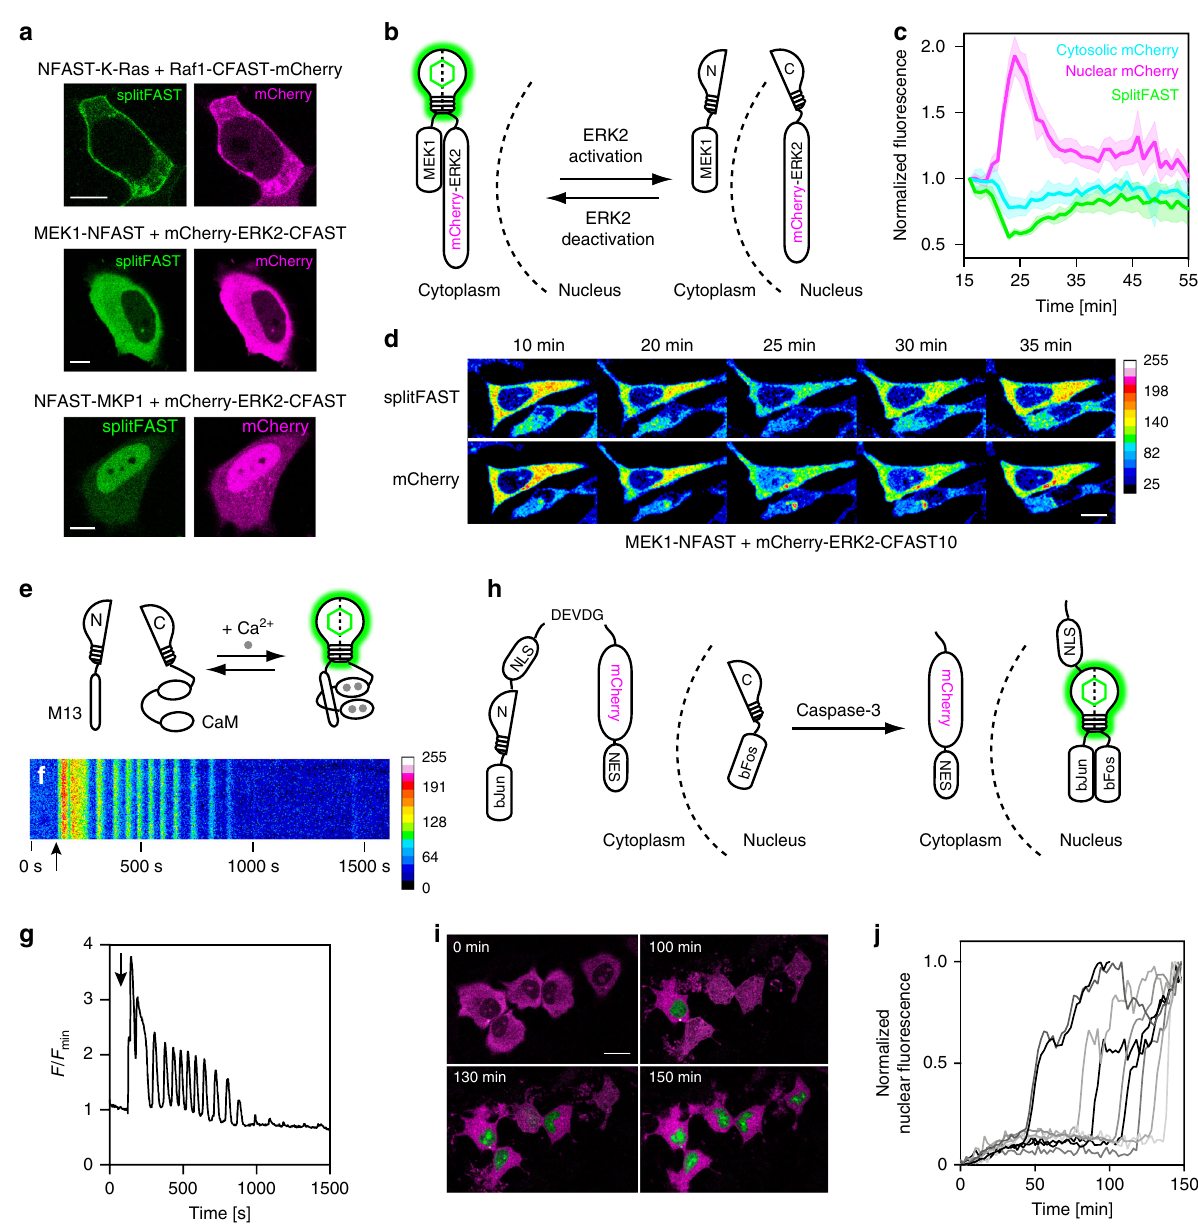
Fig. 2 Use of splitFAST for imaging protein – protein interactions and intracellular signaling. a Use of splitFAST for imaging K-Ras/Raf1, MEK1/ERK2, and ERK2/MKP1 interactions. Representative images of cells co-expressing the indicated constructs were imaged in the presence of 10 μ M HMBR (4-hydroxy- 3-methylbenzylidene rhodanine) (Supplementary Fig. 8 shows control experiments). b Use of splitFAST for imaging the evolution of MEK1/ERK2 interaction upon epidermal growth factor (EGF) stimulation. HMBR-labeled HeLa cells co-expressing MEK1-NFAST and mCherry-ERK2-CFAST10 were imaged after stimulation with EGF. c Temporal evolution of splitFAST fl uorescence (green), cytoplasmic mCherry fl uorescence (cyan), and nuclear mCherry fl uorescence (magenta) intensities (mean ± s.e.m., n = 6 cells, fi ve experiments). Data were synchronized using the beginning of the nuclear import of mCherry-ERK2-CFAST10 as reference. d Selected frames of a representative cell (see also Supplementary Movie 3). Scale bar 10 μ m. e – g Use of splitFAST for imaging of the Ca 2 + -dependent interaction of calmodulin (CaM) and the Ca 2 + -CaM interacting peptide M13. e The sensor is composed of M13-NFAST and CFAST10-CaM. f , g Temporal evolution of the intracellular fl uorescence intensity for a representative HeLa cell ( n = 14 cells from two experiments) treated with histamine (histamine addition is shown by the arrow) (see also Supplementary Movie 4). h – j Use of splitFAST for detecting caspase-3 activity. h Sensor design. i Selected merged frames from two-color imaging of representative HMBR-labeled cells ( n = 30 cells from three experiments) expressing bFos-CFAST11 and bJun-NFAST-NLS 3 -DEVDG-mCherry-NES after treatment with staurosporine (see also Supplementary Movie 5). The mCherry signal is in magenta, while the splitFAST signal is in green. Scale bar 20 μ m. j Temporal evolution of the nuclear fl